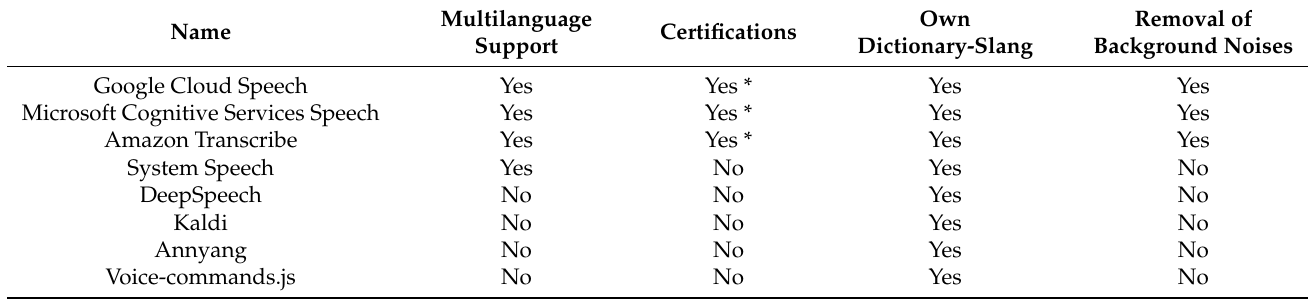
Table 1. In the following table, the capabilities of well-known speech-text-libraries are described with the focus on the certifications and language.